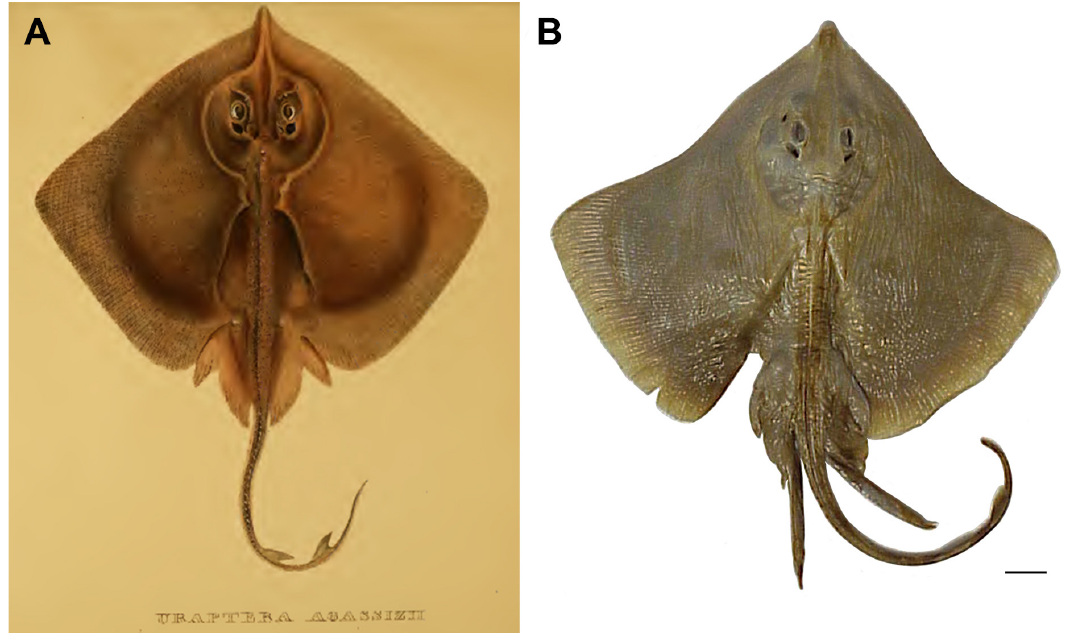
FIGURE 2 | A. Drawing of Rioraja agassizii provided by Müller, Henle (1841). B. Dorsal view of MNHN 2430, male, 405 mm TL (lectotype designated herein and modified from MNHN database). Scale bar = 20